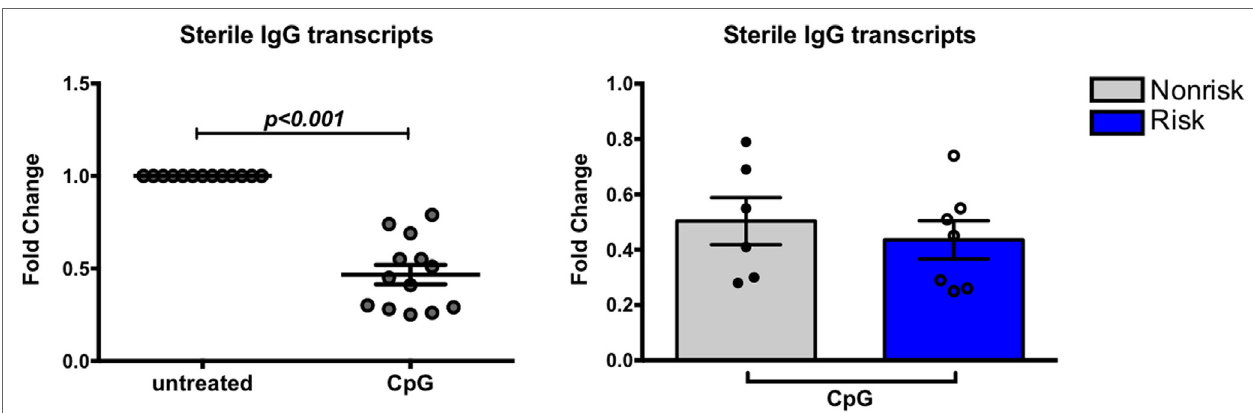
FigUre 6 | Expression of sterile transcripts in B cells. B cells were cultured for 24 h with or without CpG and subject to qPCR for germline IgG. Results are shown combined (left) and separated by haplotype (right). p < 0.001 (left) by Wilcoxon matched-pairs signed rank test, p = ns by Mann–Whitney test